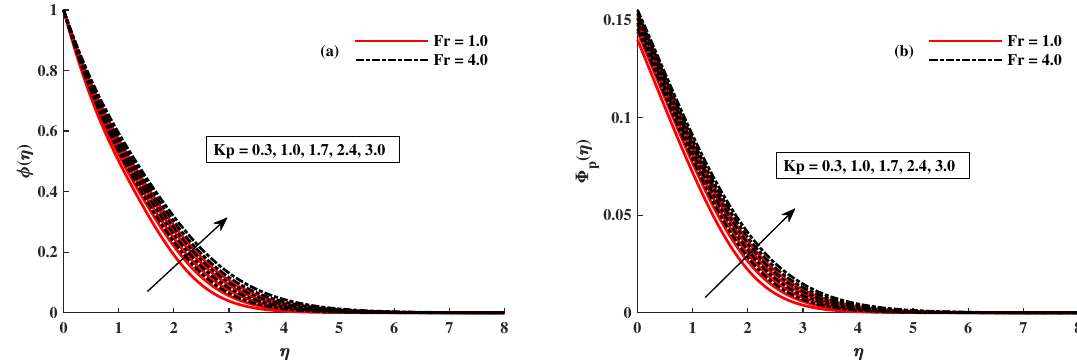
Figure 7. Variation of K p to influence the fluid and dust concentration profile.